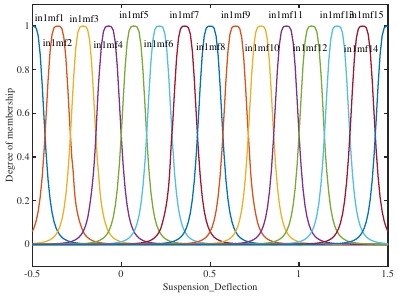
Figure 8. Membership Function of i / p variable “Suspension De- flection”